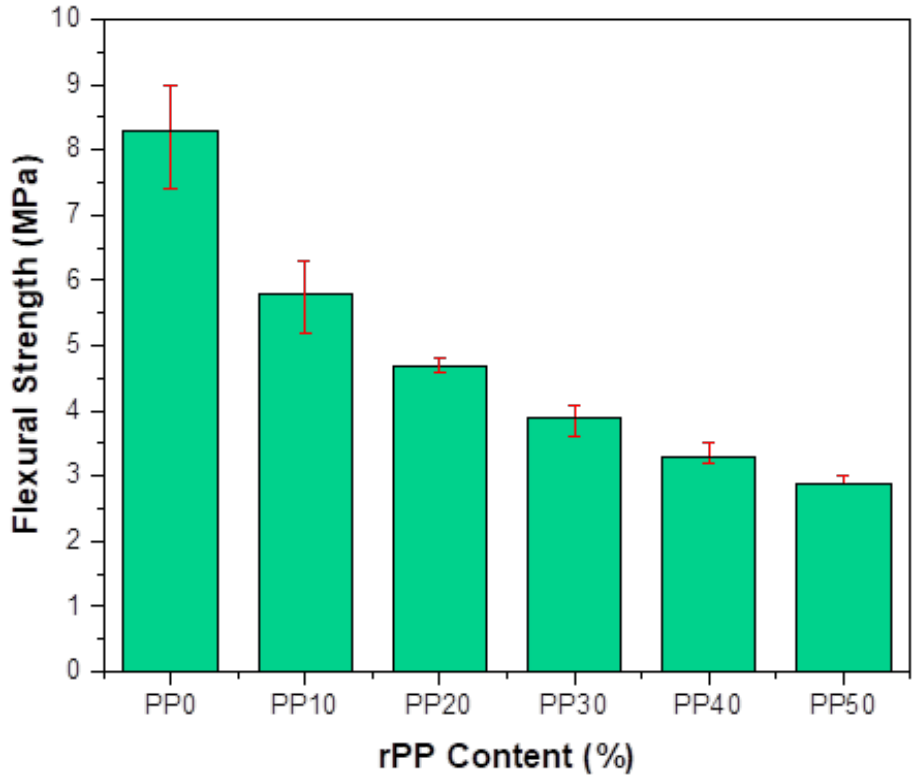
Figure 7. Flexural strength with different percentages of rPP in mortar at the age of 28 days.